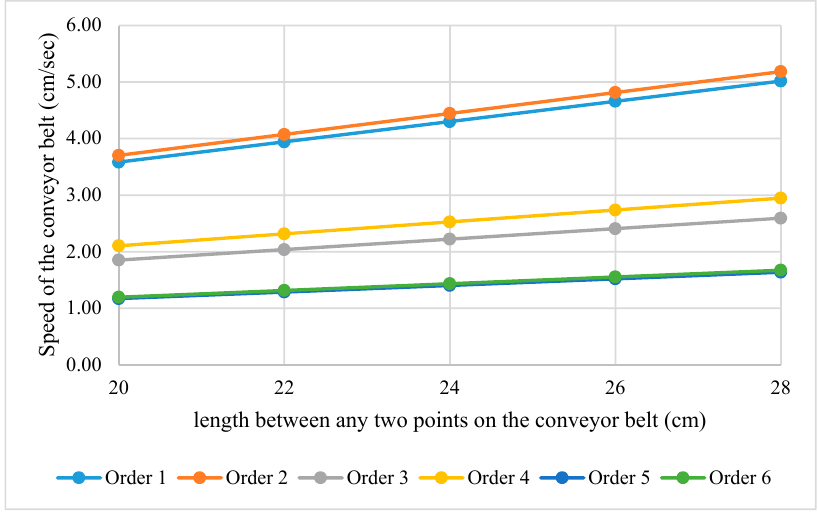
Figure 12. The effect of feed rate of yogurt valve on average minutes past due.